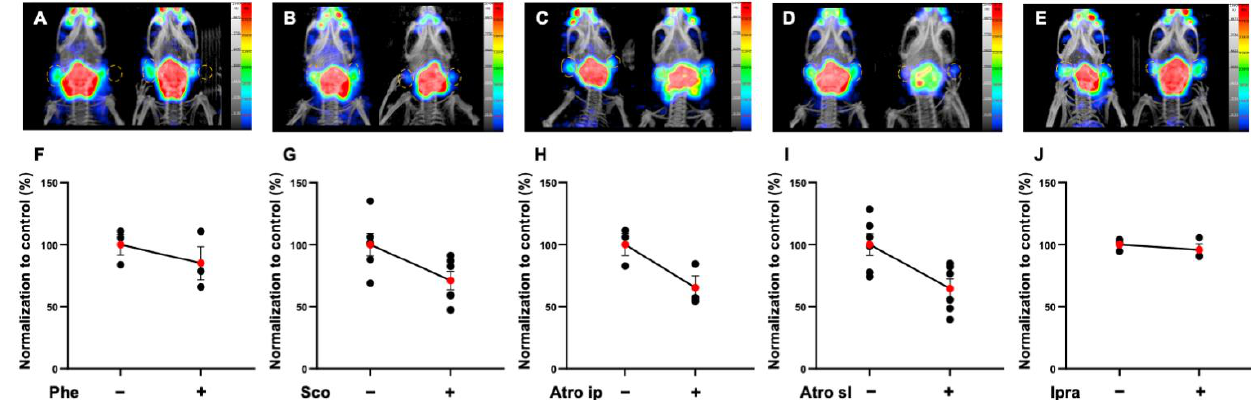
Figure 1. Representative MIP images and normalized quantification of microSPECT/CT biodis- tribution of [ 99m Tc]TcO 4 − in parotid glands at 45 min after injection in non-tumor-bearing mice premedicated with phenylephrine (Phe) 5 mg kg − 1 ip ( A , F ), scopolamine (Sco) ip 5 mg kg − 1 ( B , G ), atropine (Atro) ip 15 mg kg − 1 ( C , H ), atropine sl 15 mg kg − 1 ( D , I ), or ipratropium sl 4 mg kg − 1 ( E , J ). Red points represent the mean ± SEM; black points represent the sample dispersion. (Statistical test has been performing using paired t -test. Table 2. Quantifications of [ 99m Tc]TcO 4 − in the parotid glands at 45 min after injection in non-tumor- bearing mice (ns: not significant; * p < 0.05; ** p < 0.01)